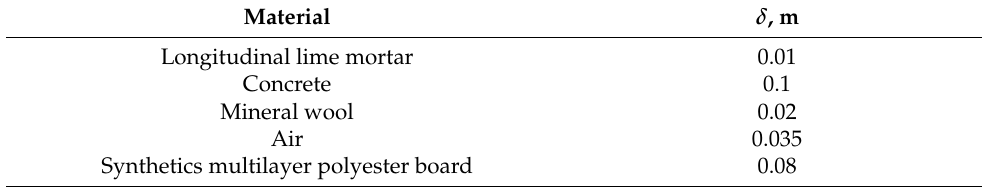
Table 2. External wall of the ventilated façade with the minimum layer thickness.